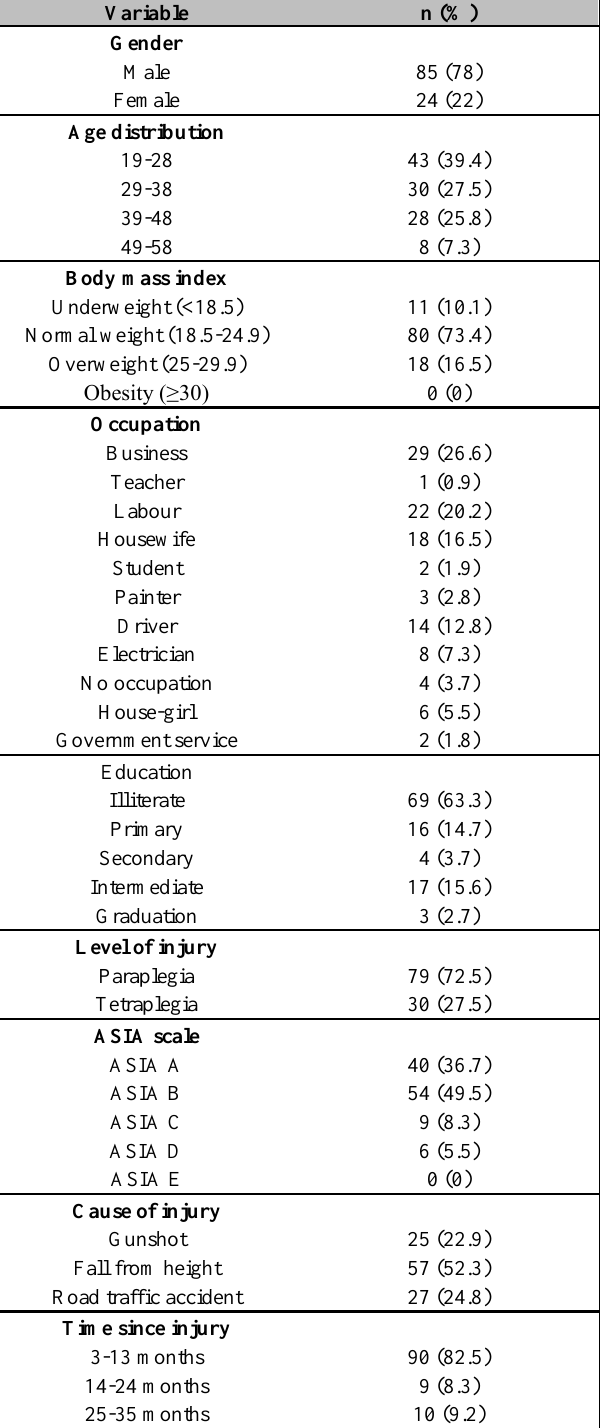
Table 1: Characteristics, frequencies and percentages of